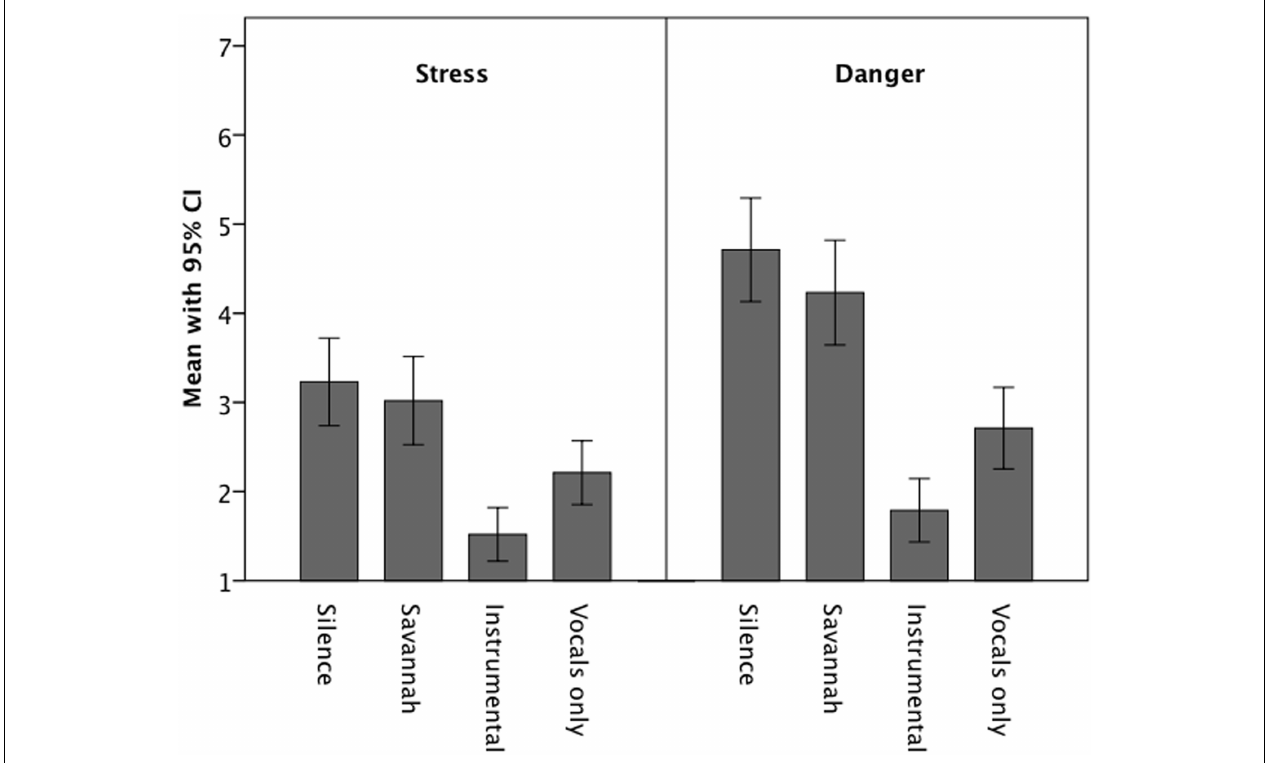
FIGURE 2 | Means (and 95% confidence intervals) of stress and danger ratings for the four sound